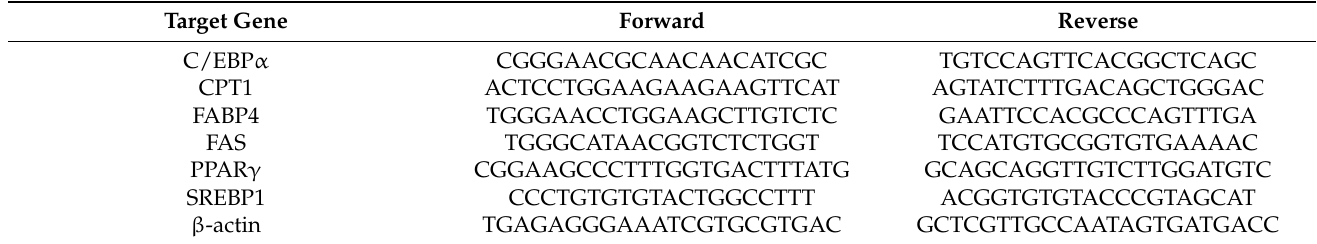
Table 1. Sequences of primers for mRNA used in